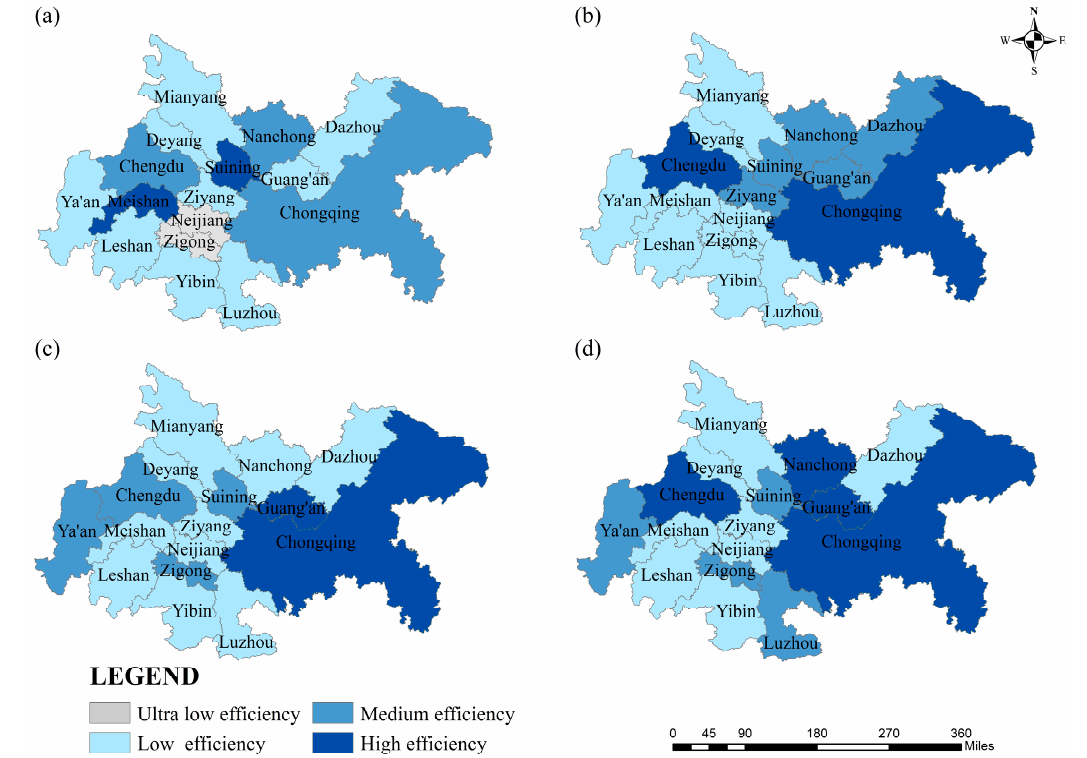
Figure 2. Spatial distribution pattern of green technology innovation efficiency in the Chengdu– Chongqing urban agglomeration. ( a ) 2011. ( b ) 2014. ( c ) 2017. ( d ) 2019. Chongqing urban agglomeration. ( a ) 2011. ( b ) 2014. ( c ) 2017. ( d )